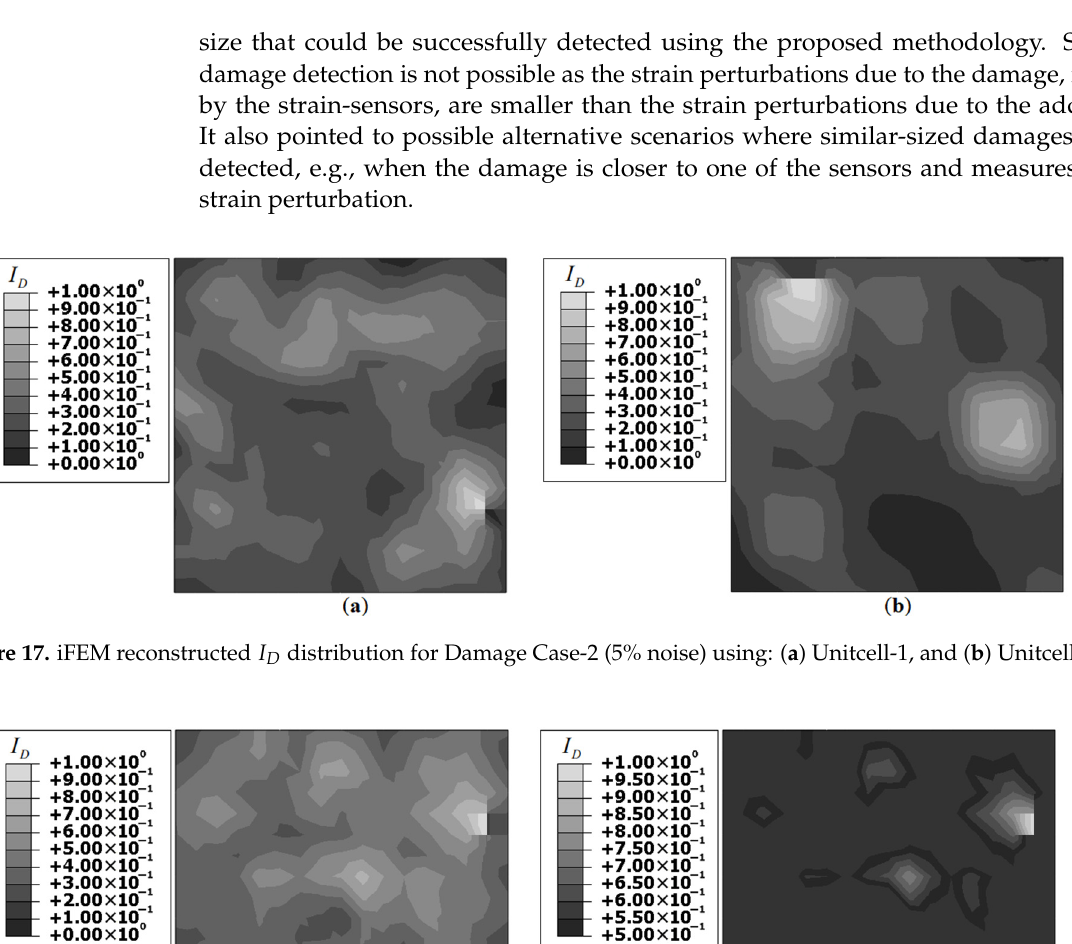
Figure 19. iFEM reconstructed 𝐼 (cid:3005) distribution for Damage Case-3 using: ( a ) Unitcell-1, and ( b ) Unitcell-2.